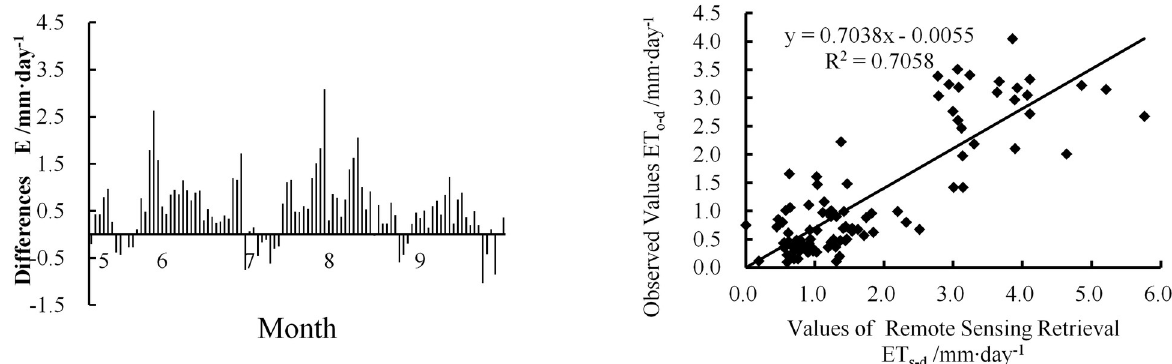
Fig 4. Comparison between the estimated and observed ET: (a) distribution map of the difference between the estimated and observed daily ET and (b) correlation between the estimated and observed daily ET.